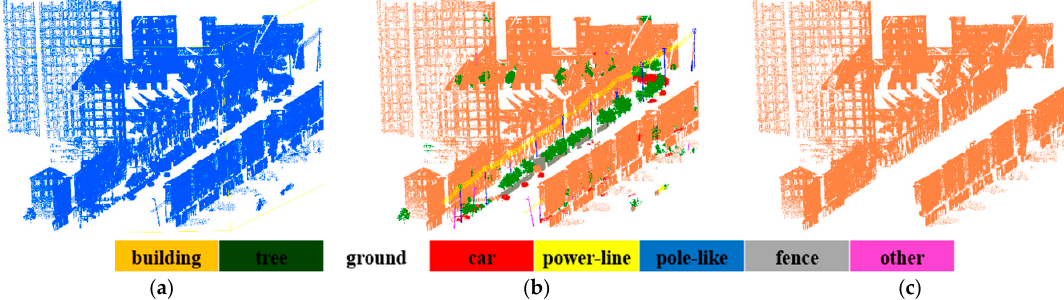
Figure 11. The results of building extraction on dataset A. ( a ) Raw data; ( b ) the final results of semantic segmentation; ( c ) the results of building extraction.